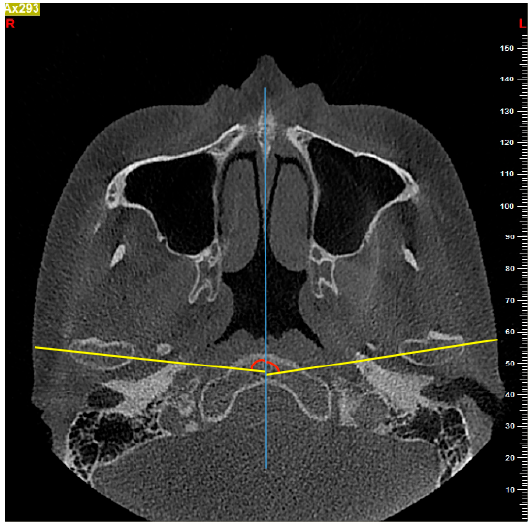
Figure 1. The measurement of condylar angle (CA) on the axial slice. The angle between the long axis of the condyle (yellow line) and the midsagittal plane (blue line) was measured.